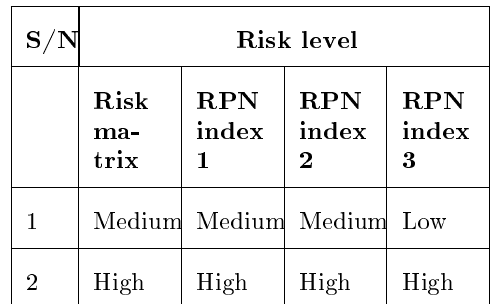
Tab. 15: Comparison of methods based on failure modes risk